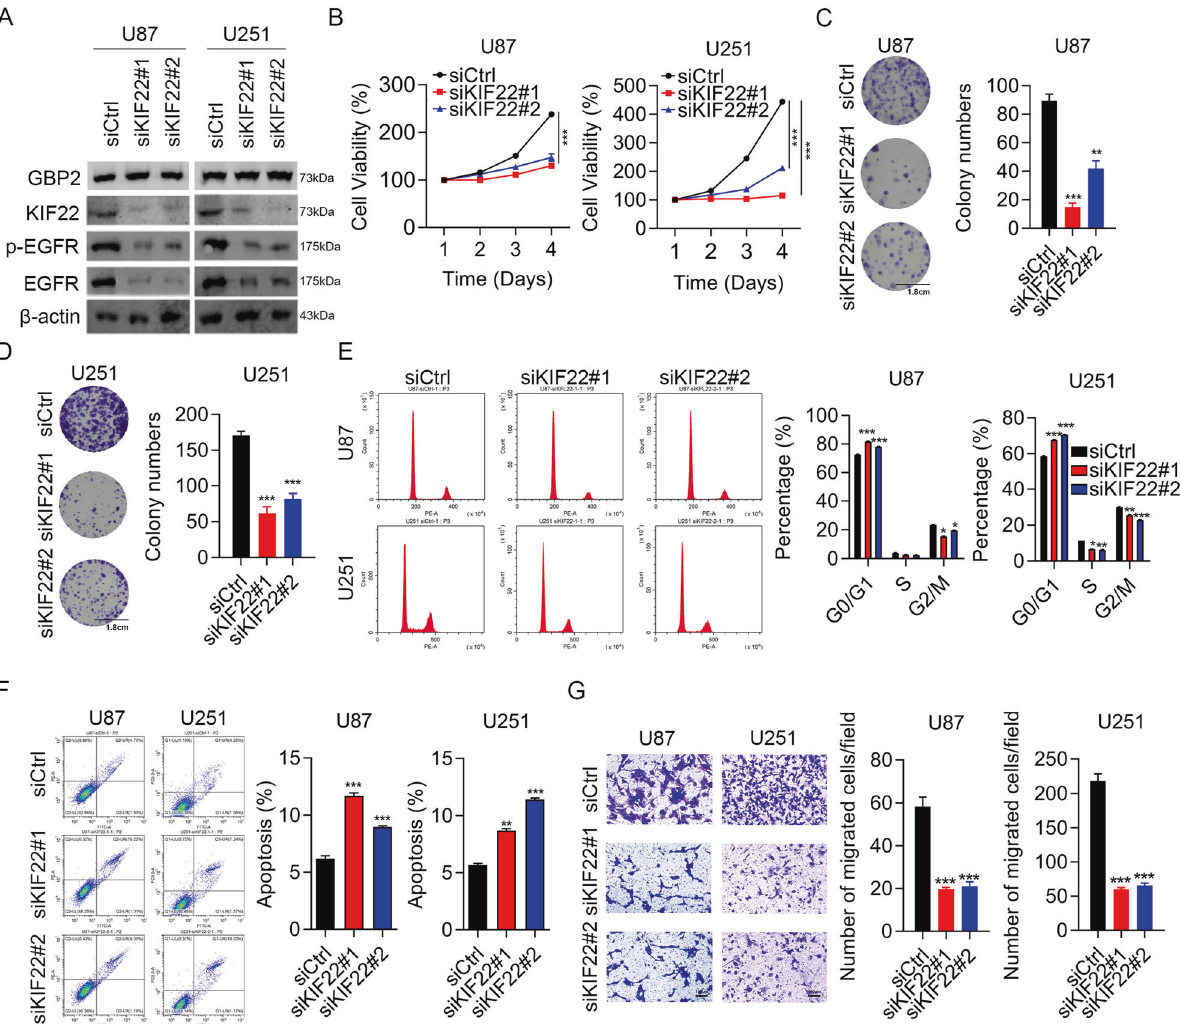
Fig. 6 Knockdown of KIF22 impaired proliferation and migration in glioma cells. A Western blotting results con fi rming KIF22 knockdown ef fi ciency, and showing expression of proteins related to EGFR signaling pathway in U87 and U251 cells transfected with siCtrl, siKIF22#1, or siKIF22#2. B CCK8 assay results for U87 and U251 cells transfected with siCtrl, siKIF22#1, or siKIF22#2. C , D Colony formation assay results for U87 and U251 cells transfected with siCtrl, siKIF22#1, and siKIF22#2. E Cell cycle assay results for U87 and U251 cells transfected with siCtrl, siKIF22#1, or siKIF22#2 using PI staining. F Apoptosis assay results for U87 and U251 cells using annexin V and PI staining. G Transwell invasion assay results for U87 and U251 cells. Each experiment repeated as least 3 times. Magni fi cation: ×10. * P < 0.05, ** P < 0.01, *** P <